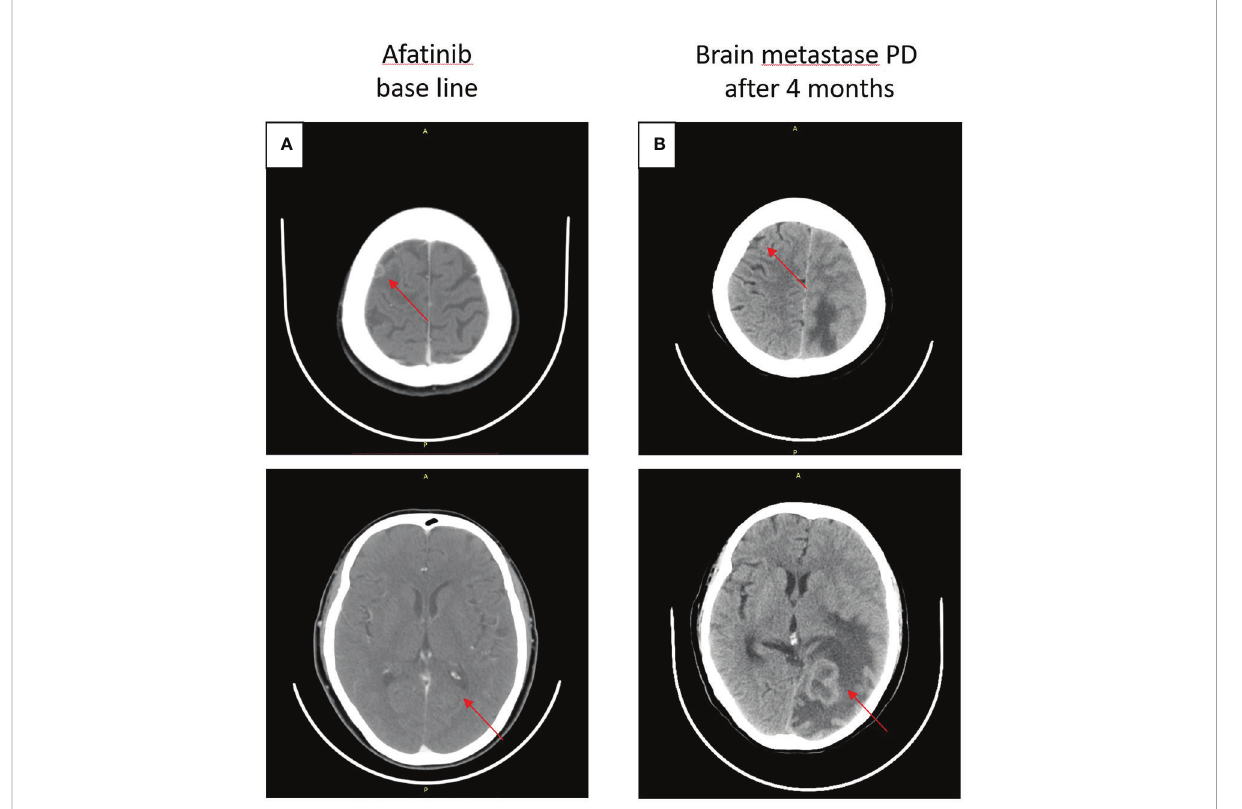
FIGURE 2 Craniocerebral CT about clinical response to afatinib therapy at different times. (A) Baseline before afatinib treatment. (B) Brain metastases progressive disease (PD) after 4